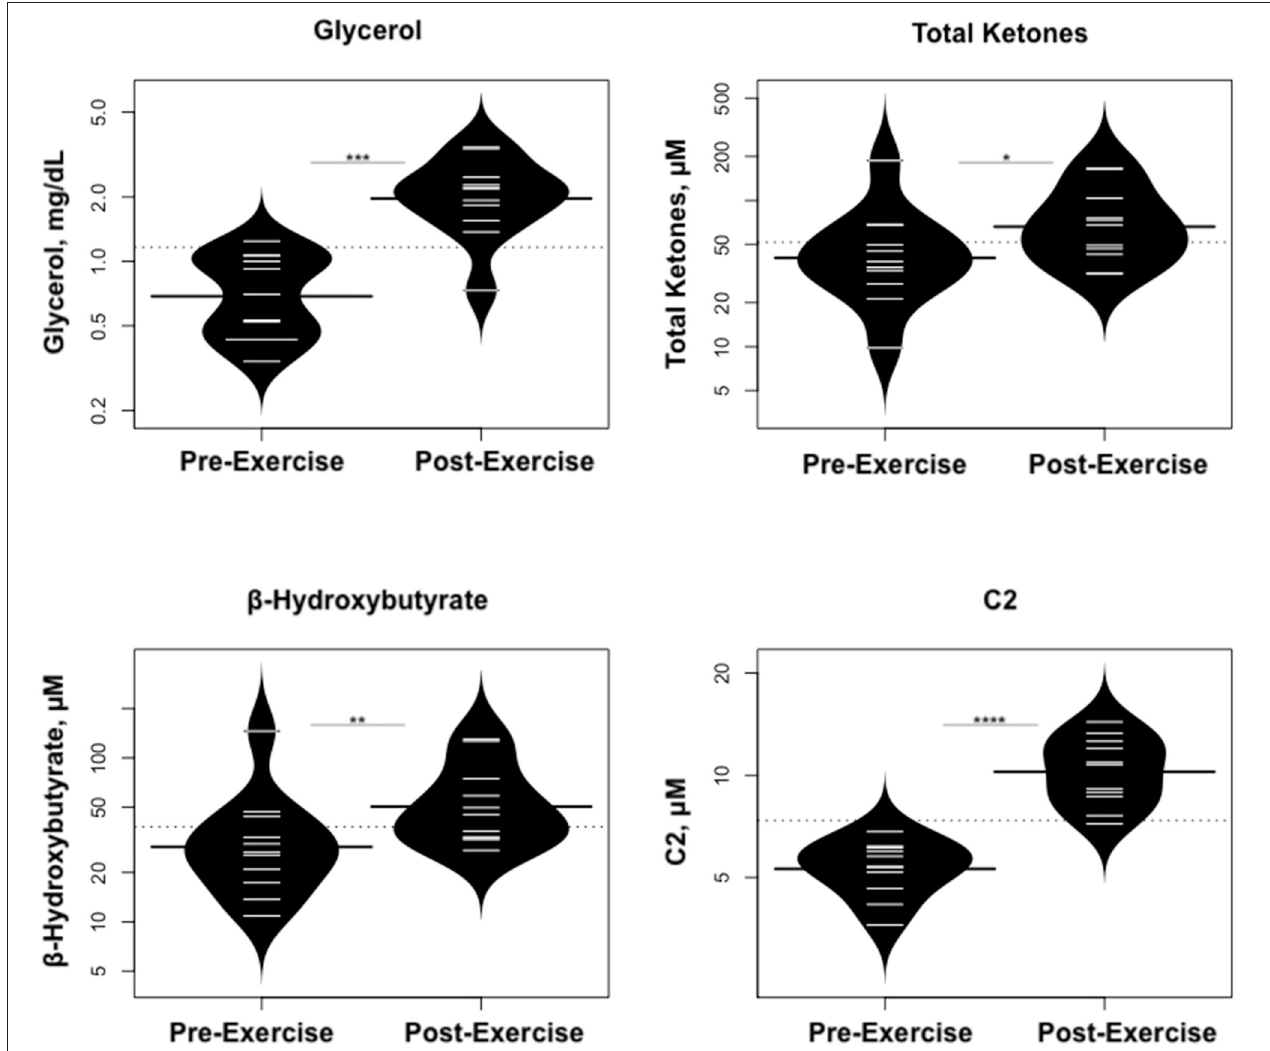
FIGURE 3 | Changes in metabolites related to lipolysis/FAO. * p < 0.01, ** p < 0.001, *** p < 0.0001, **** p < 0.00001.